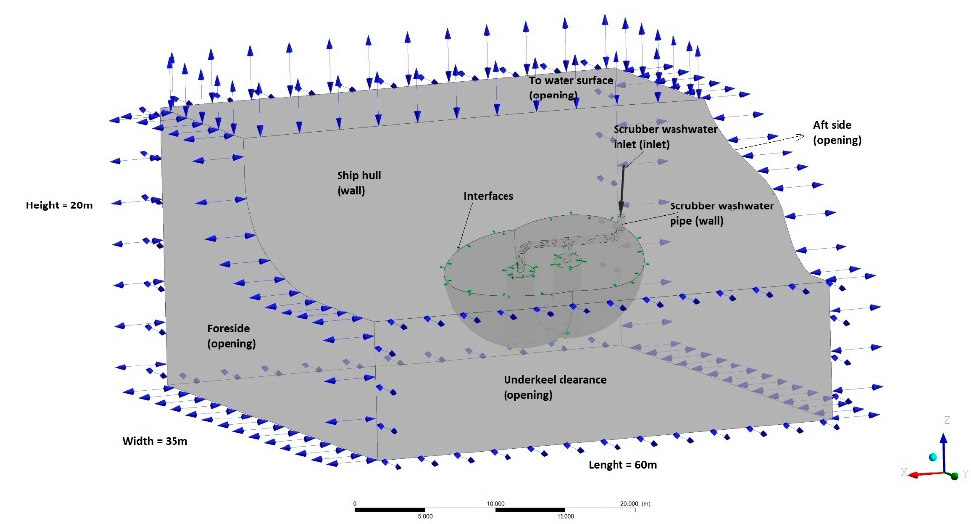
Figure 3. Boundaries of the computational domain.